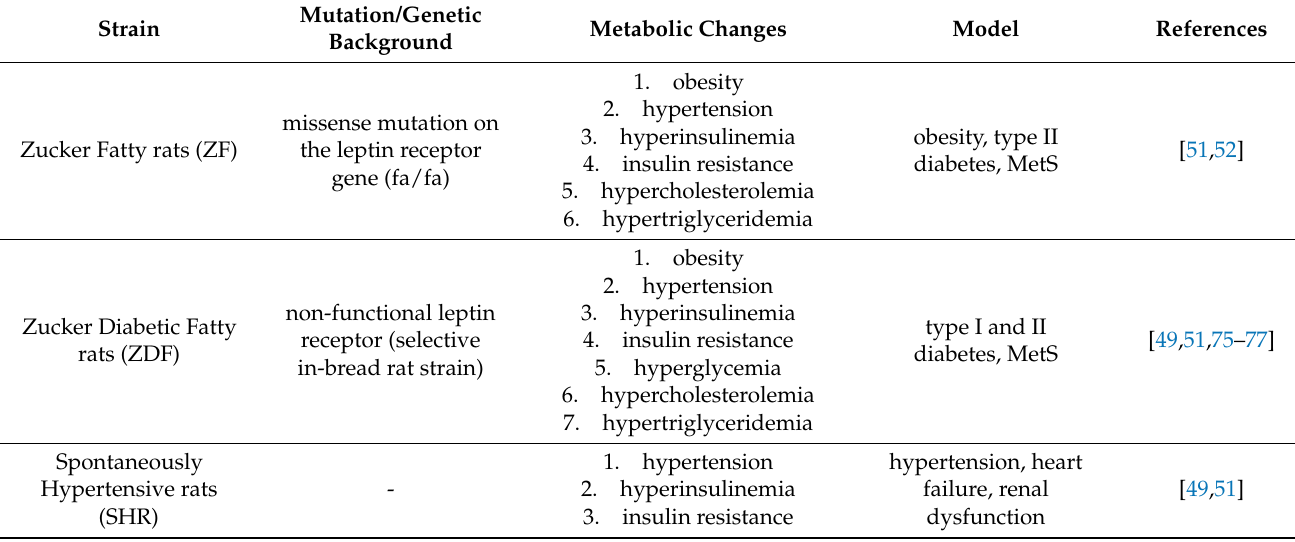
Table 1. The characterization of metabolic changes in genetic animal models of metabolic syndrome. Mutation/Genetic Metabolic Strain Background